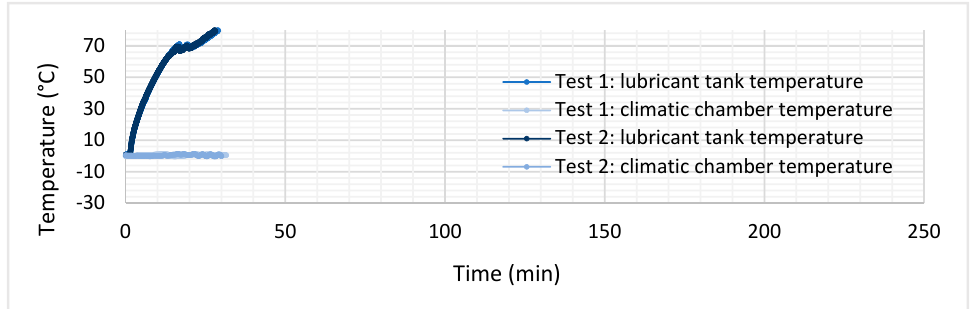
Figure A1. Lubricant tank and climatic chamber temperature trend at a thermostatic temperature of 0 °C during the two repetitions.